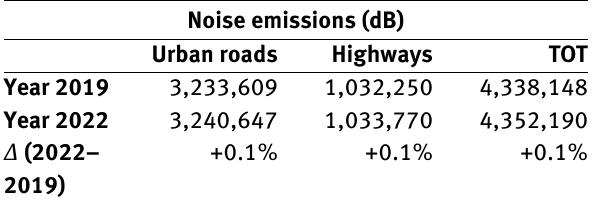
Table 5: Noise emissions